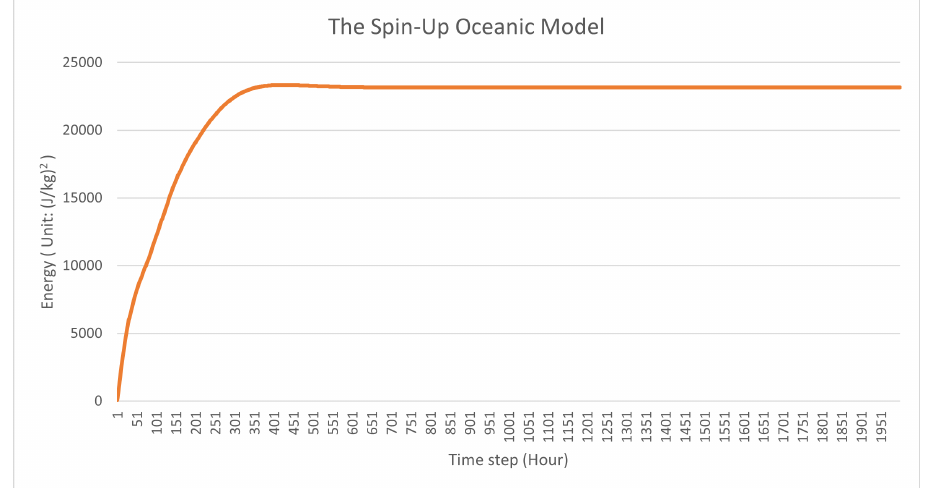
Figure 5. Spin-Up Oceanic Model.